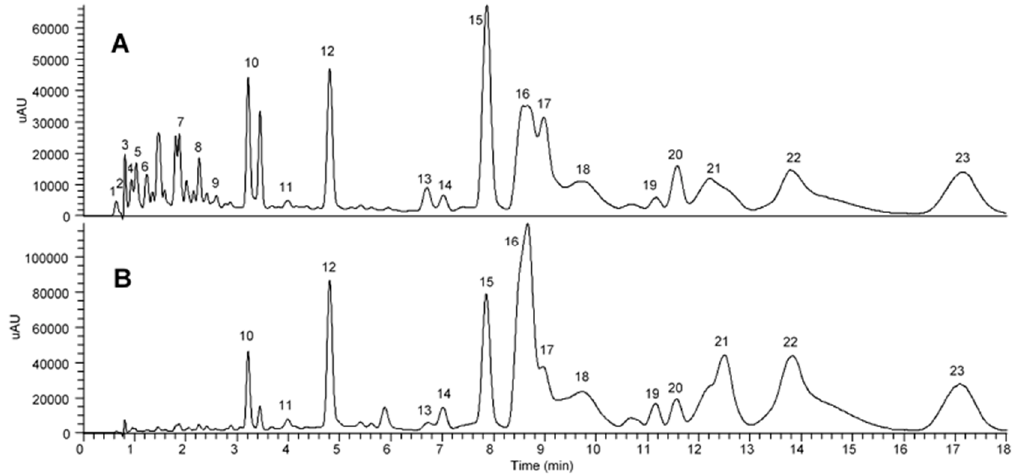
Figure 6. UHPLC–UV / PDA chromatograms of ( A ) crude OPL extract and ( B ) total flavonoid-enriched OPL extract at 340 nm.